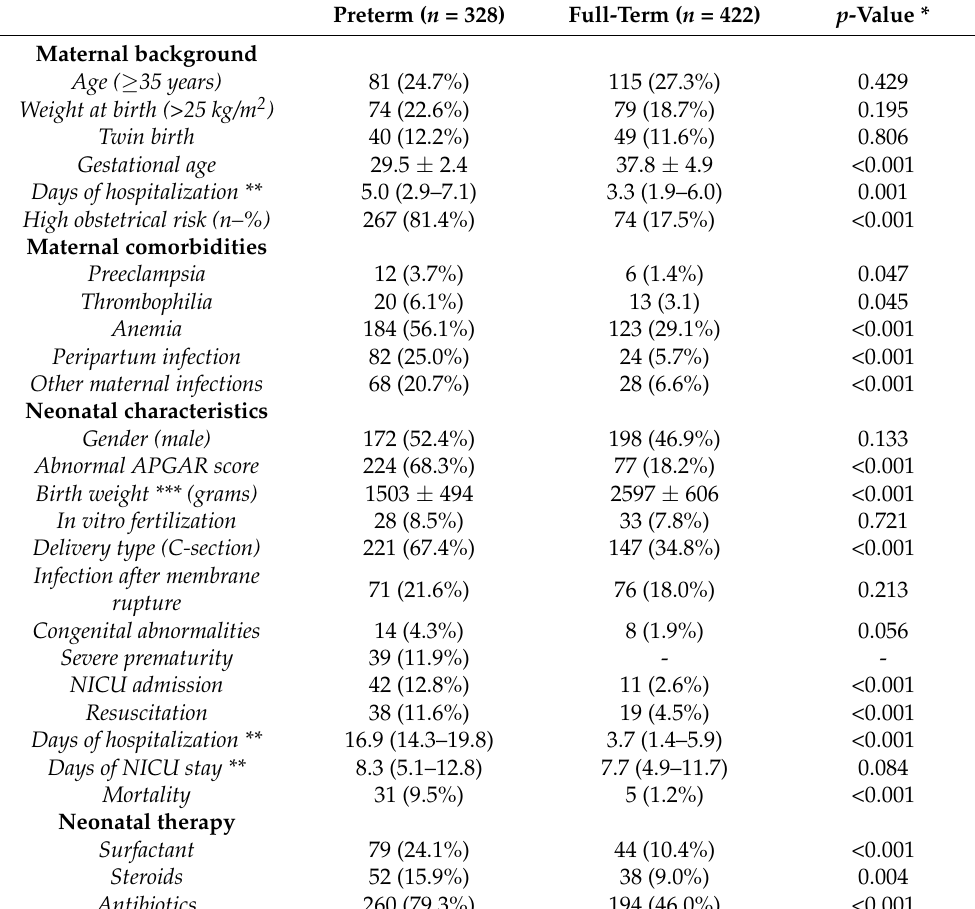
Table 1. Comparison of maternal and neonatal characteristics between the group of preterm births and the group of full-term